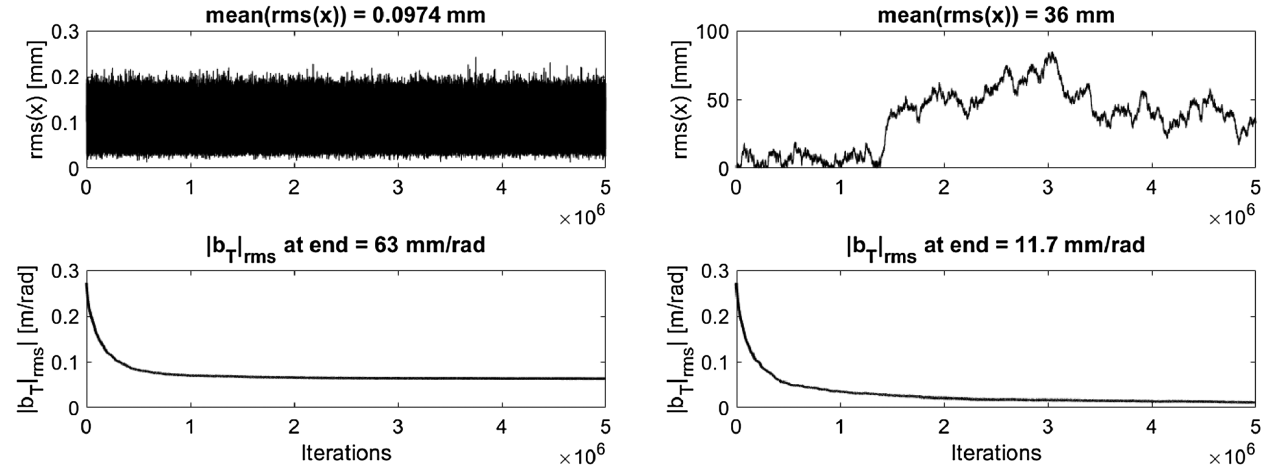
FIG. 12. Left: one position monitor is removed ( n < m ), which spoils the convergence of j b T j rms to zero, but maintains a small orbit. Right: one corrector magnet is removed ( n > m ); now the identification of the response matrix works well and j b T j rms converges to zero, but the orbit is not corrected